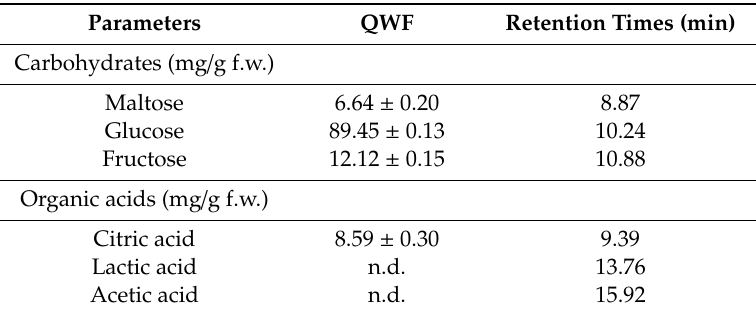
Table 1. Carbohydrates and organic acids content of quinoa